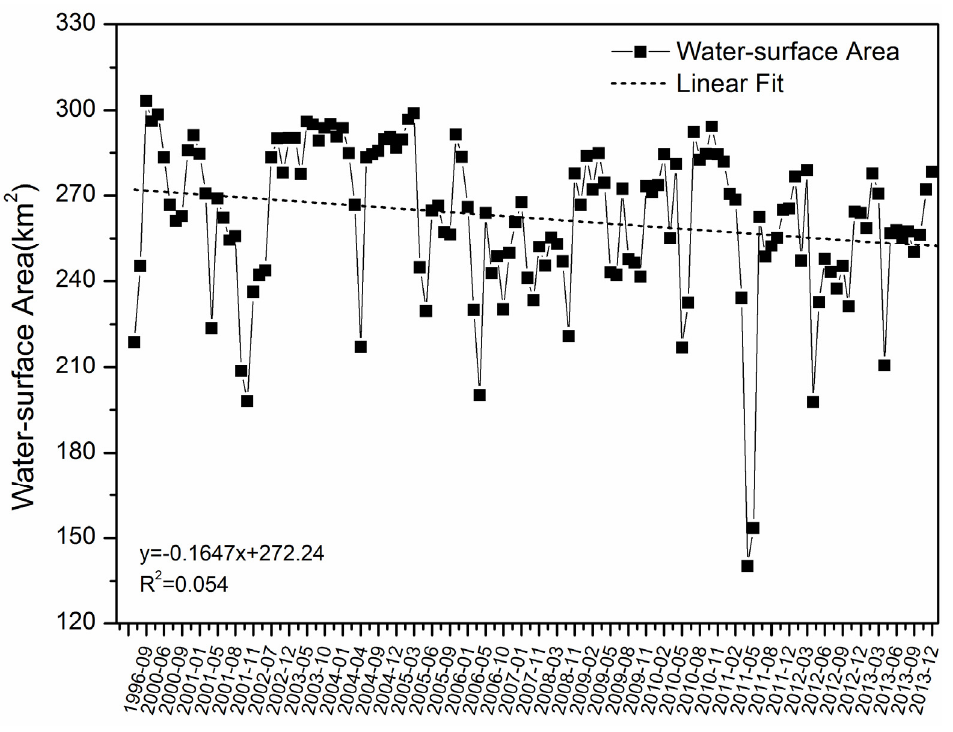
Figure 4. Curve of water-surface area variations of the Honghu Lake from the 1990s to